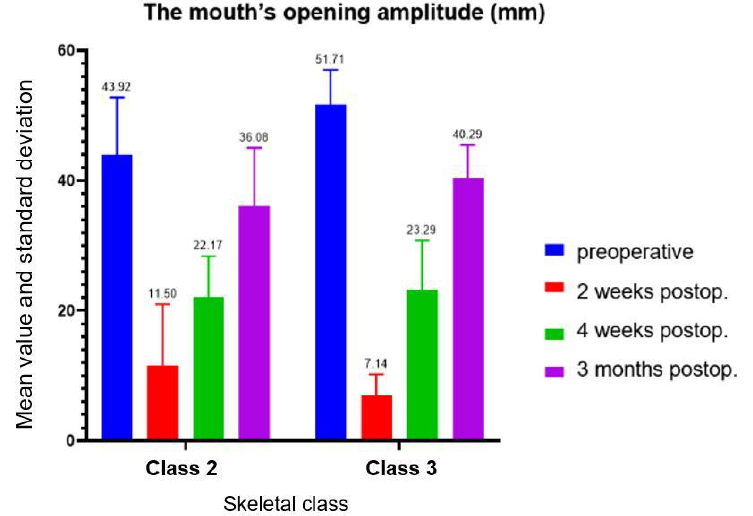
Figure 7. Mouth’s opening amplitude.